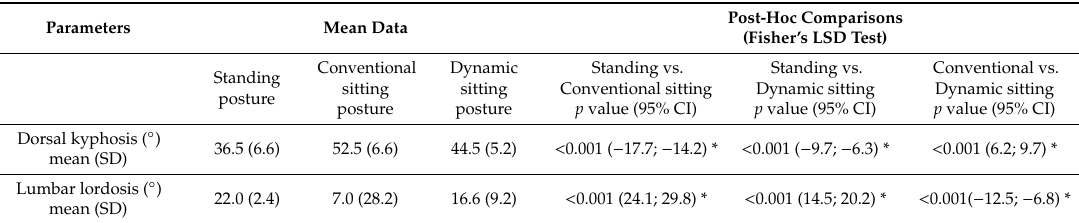
Table 2. Mean data and post-hoc